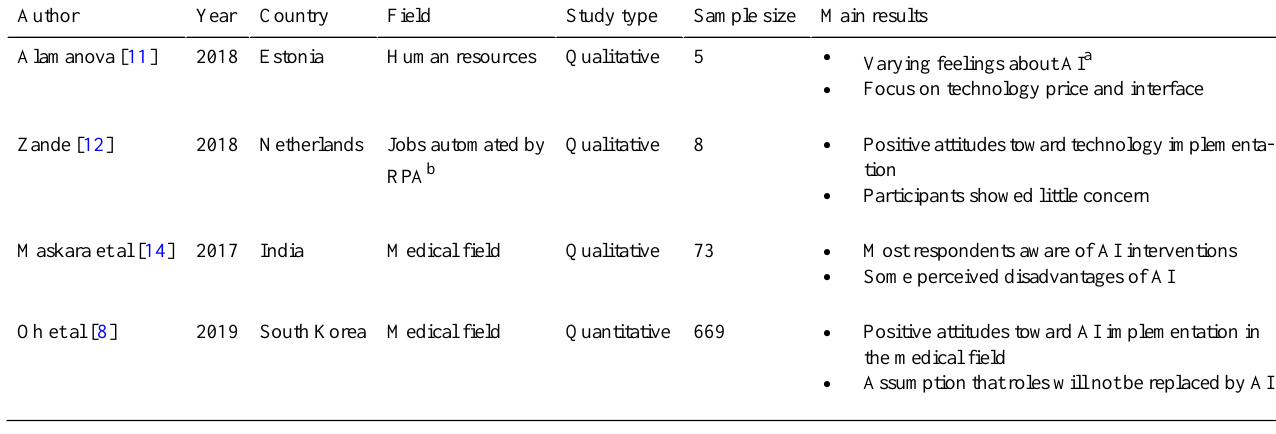
Table 1. Summary of related studies.